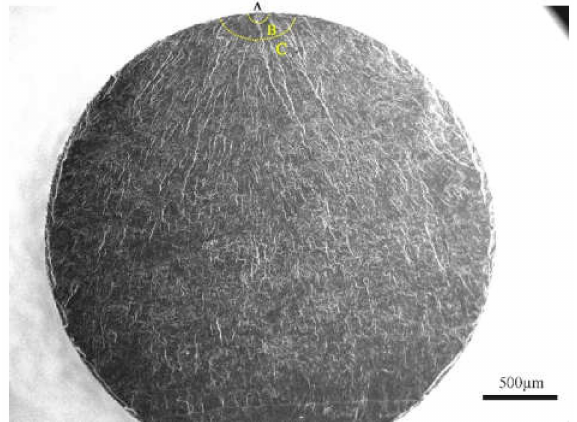
Figure 8. Overview of the fracture surface, R = − 1, σ a = 150 MPa, N f = 6.24 × 10 7